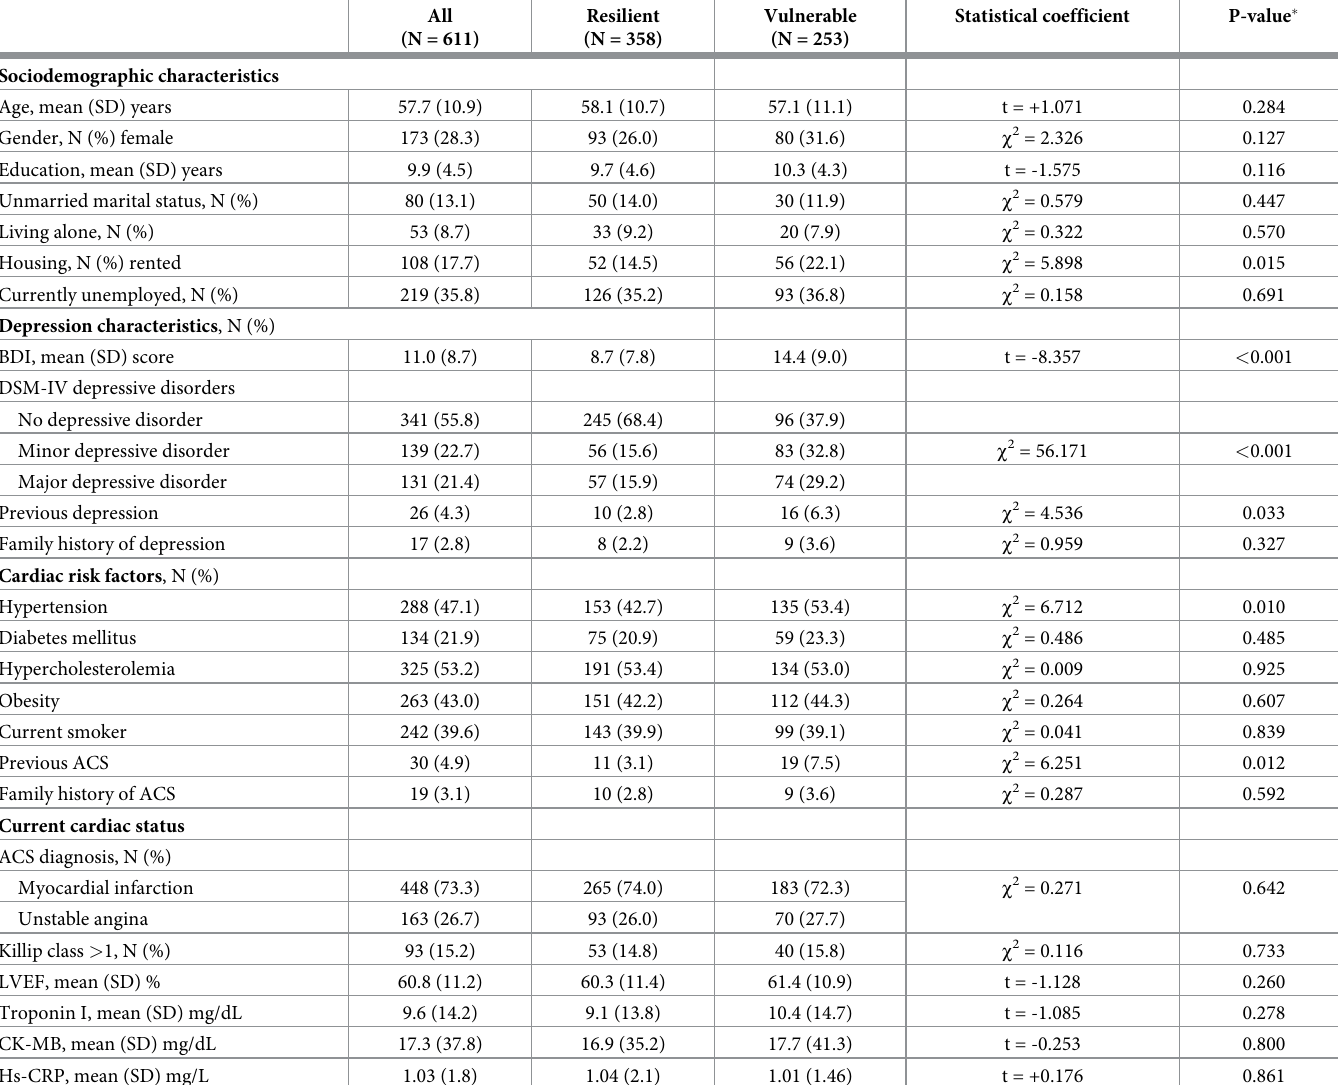
Table 1. Baseline characteristics according to personality type in 611 patients with acute coronary syndrome